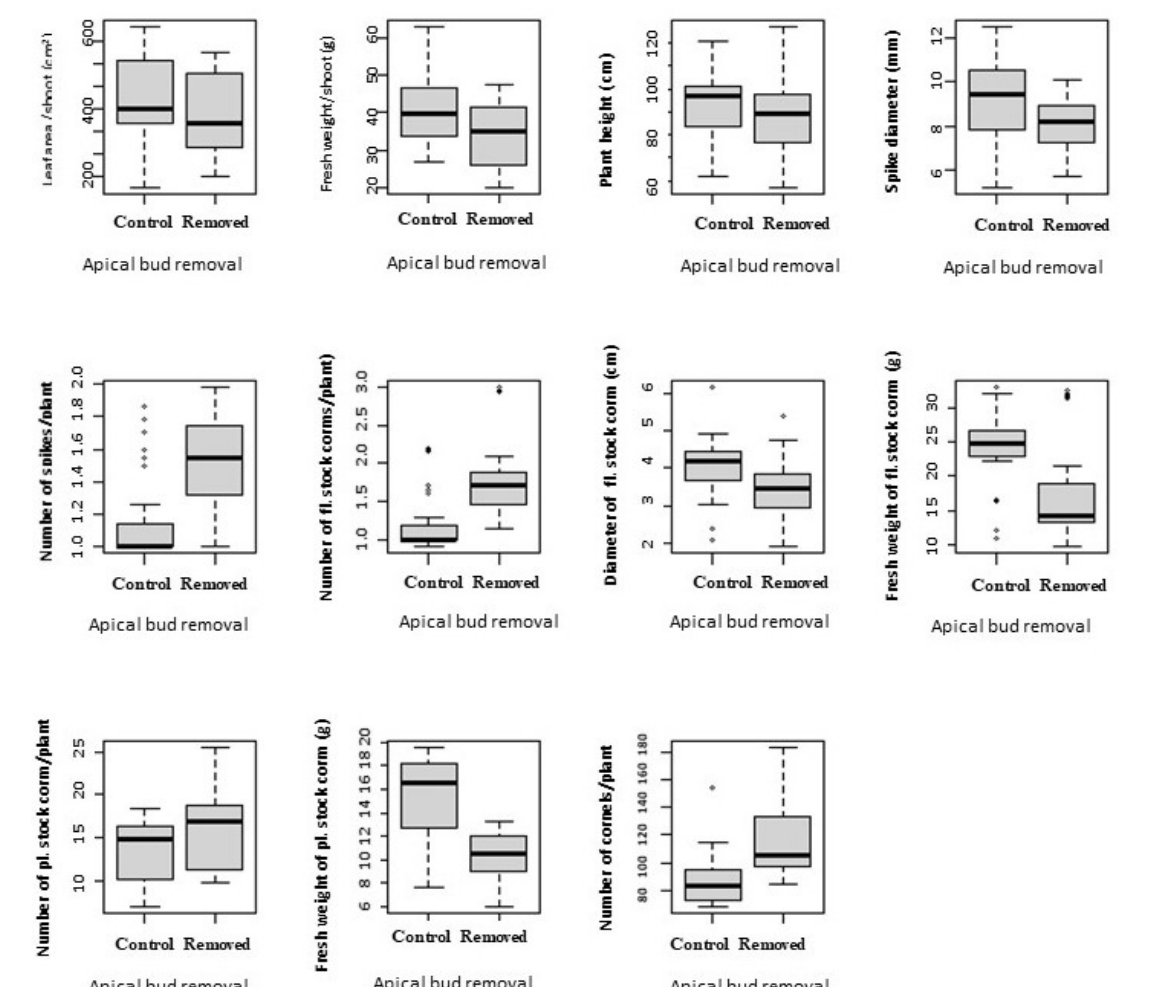
Figure 3. The effect of growth regulators on the different corm and leaf variables illustrated as boxplots where the boxes define a lower and an upper percentile, in which 75% of the observations are found, and the marked line defines the median value of a given